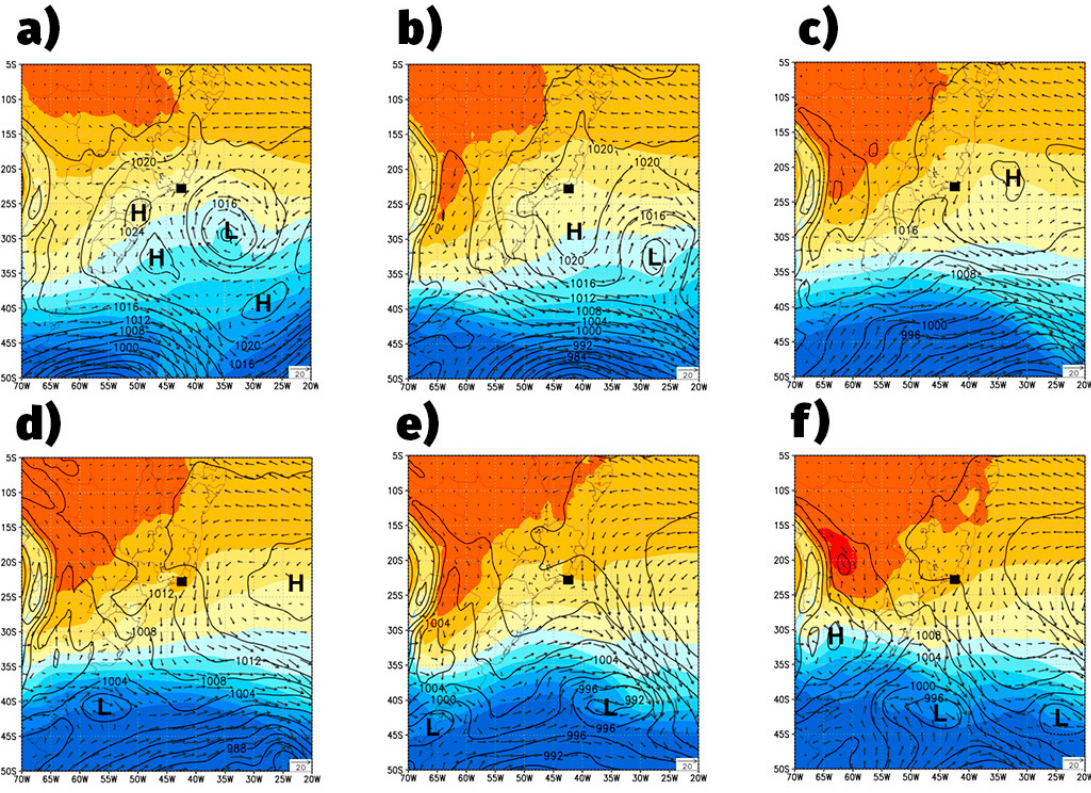
Figure 1. Evolution of synoptic situation over Brazil during Rio Olympics. Black isolines: Sea Level Pressure (hPa). Color Shades: 1000-500 hPa thickness (m). Vectors: 10 m wind (m s -1 ) for 12 UTC on 12 ( a ), 13 ( b ), 14 ( c ), 15 ( d ), 16 ( e ) and 17 ( f ) August 2016. City of Rio de Janeiro marked with a dark square on the maps. High and Low Pressure Centers are marked with H and L, respectively